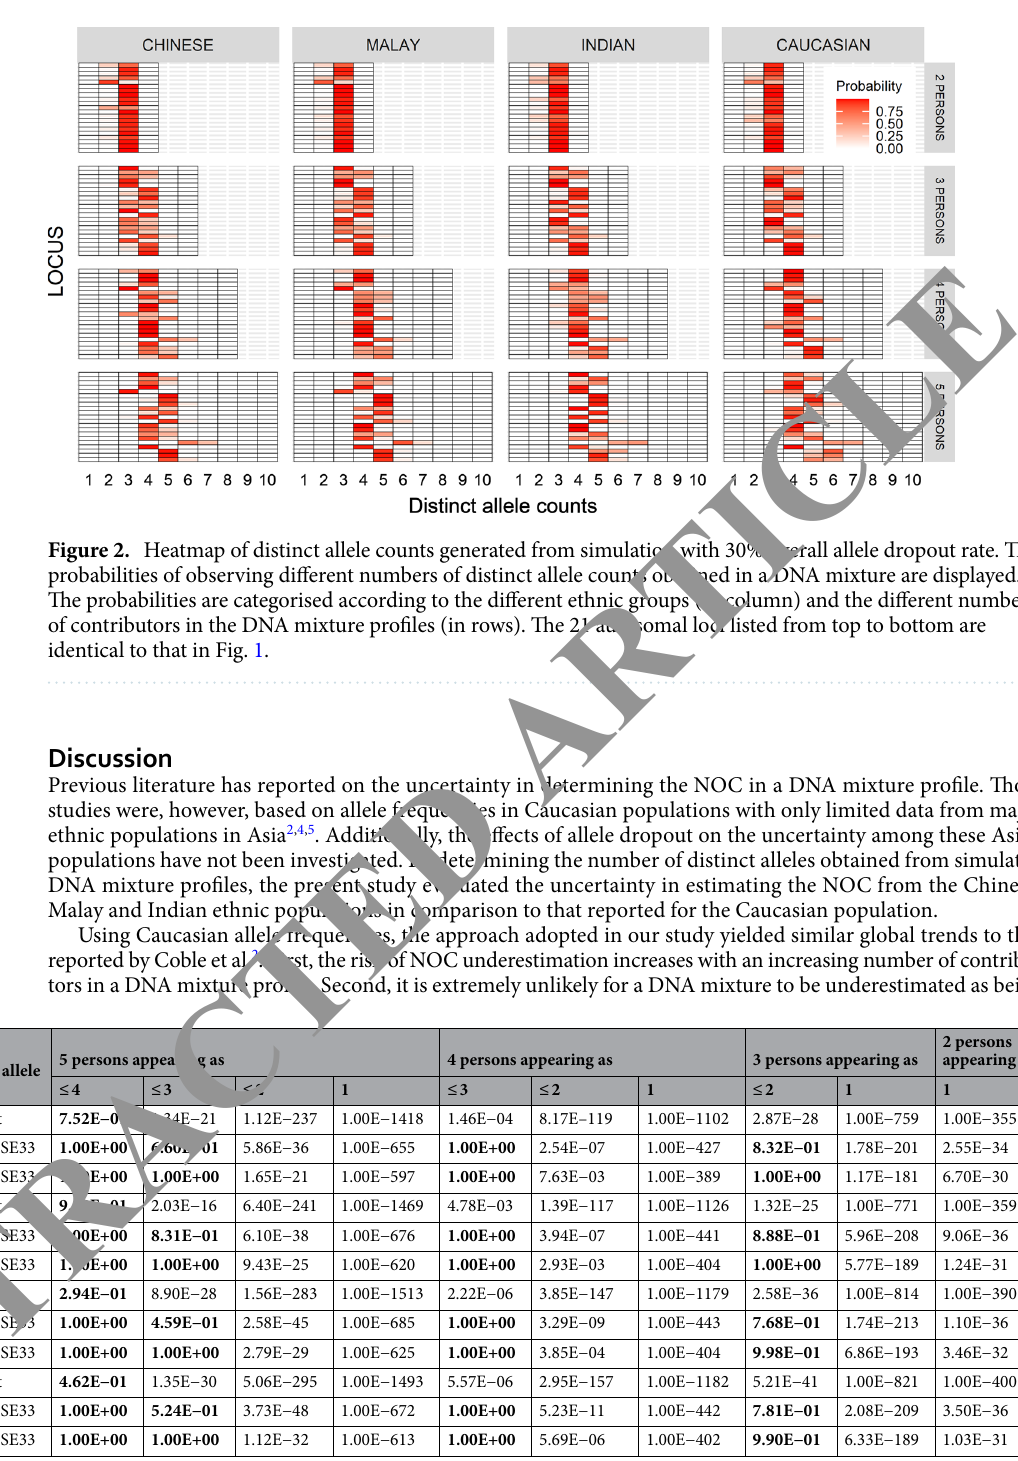
Table 1. Cumulative probabilities (risk) of observing k number of contributors and fewer, in a DNA mixture profile derived from N number of contributors, where k = 1, . . . , N − 1 . The results are categorised into each ethnic group, before further differentiation into scenarios with allele dropout or no allele dropout. DNA mixture profiles with allele dropout are further differentiated according to whether SE33 is included (+ SE33) in the cumulative probability calculations or without SE33 (− SE33). Results in bold denote having a cumulative probability of ≥